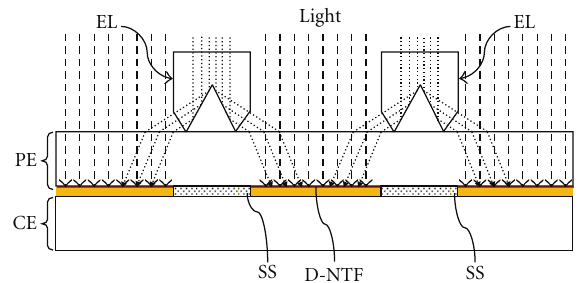
Figure 1: Illumination of DSSC.